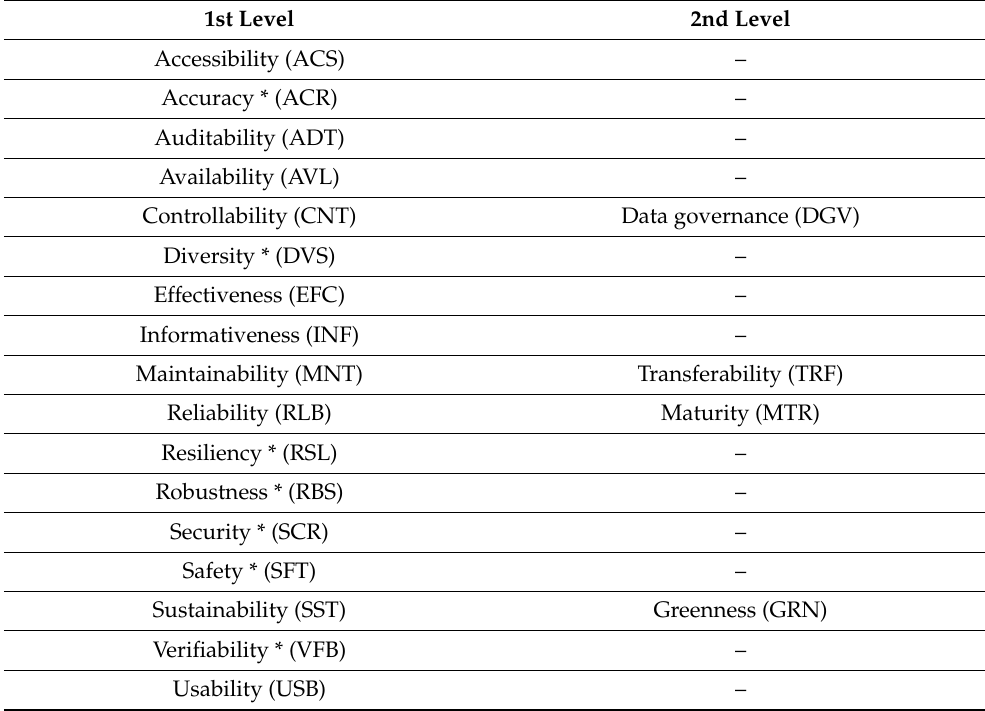
Table 6. The tabular representation of the AI platform quality model QS ChAIP